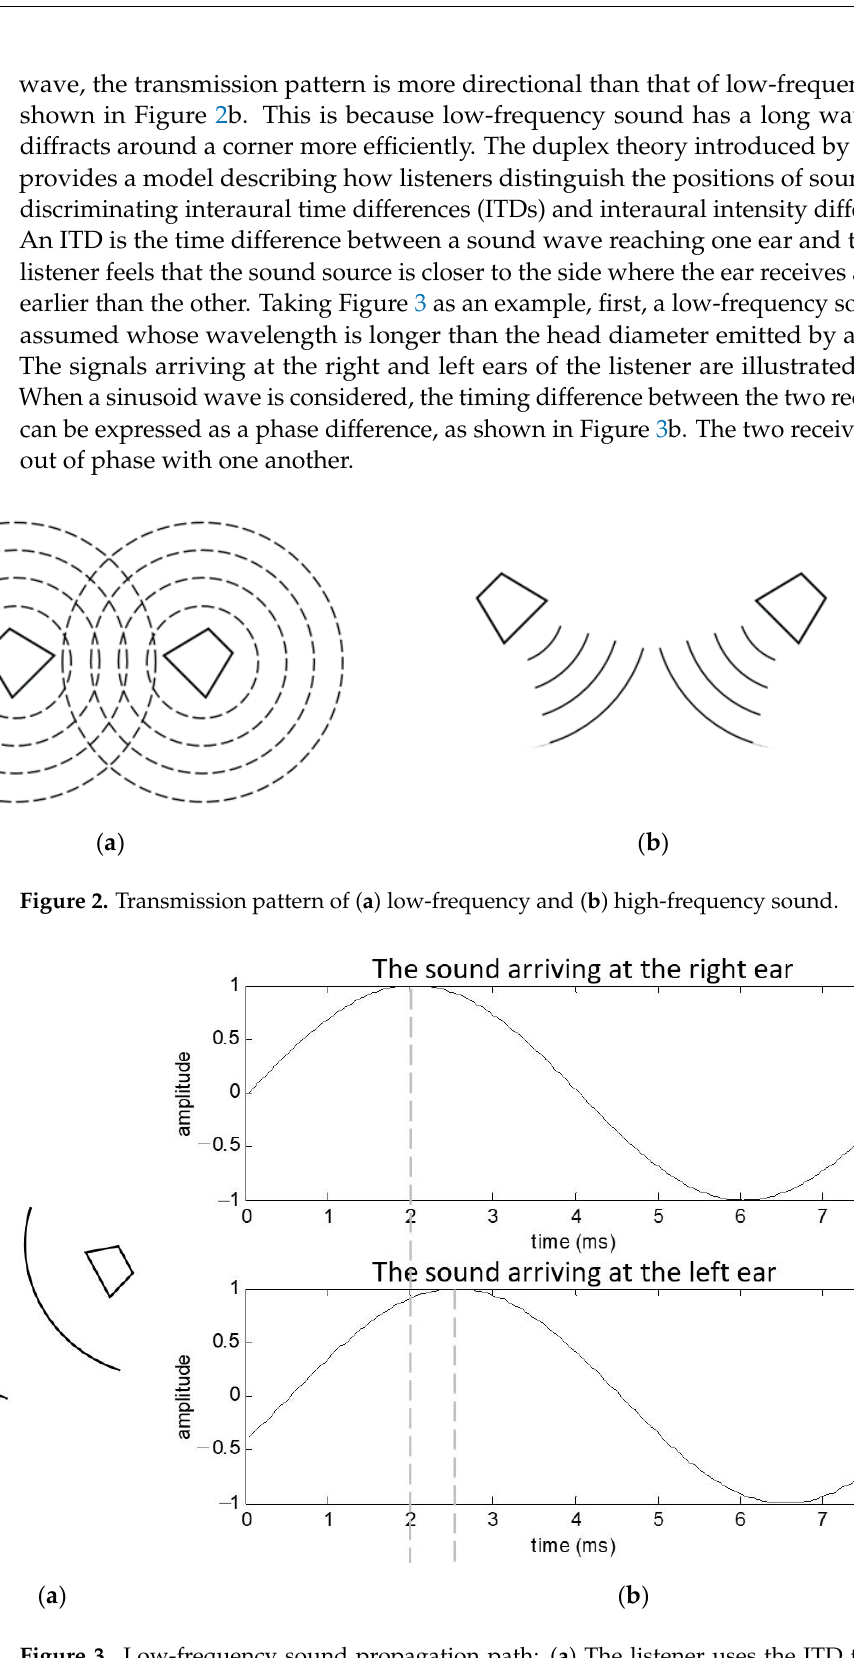
Figure 3. Low-frequency sound propagation path: ( a ) The listener uses the ITD to estimate the location of a low-frequency sound source. ( b ) The listener’s right ear receives the signal first, and the timing difference is the cause of the phase difference between two